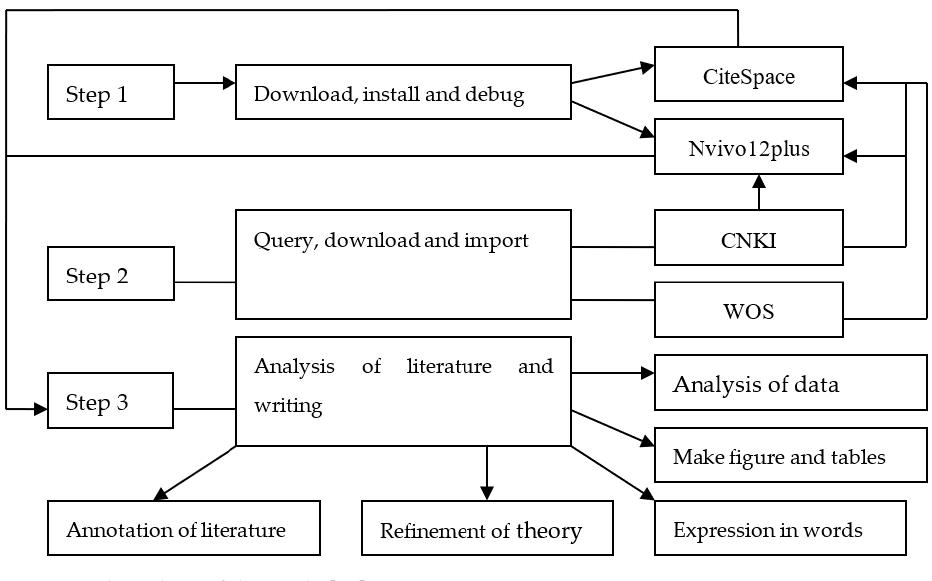
Figure 1. Flow chart of the study Figure 1 . Flow chart of the study [56].